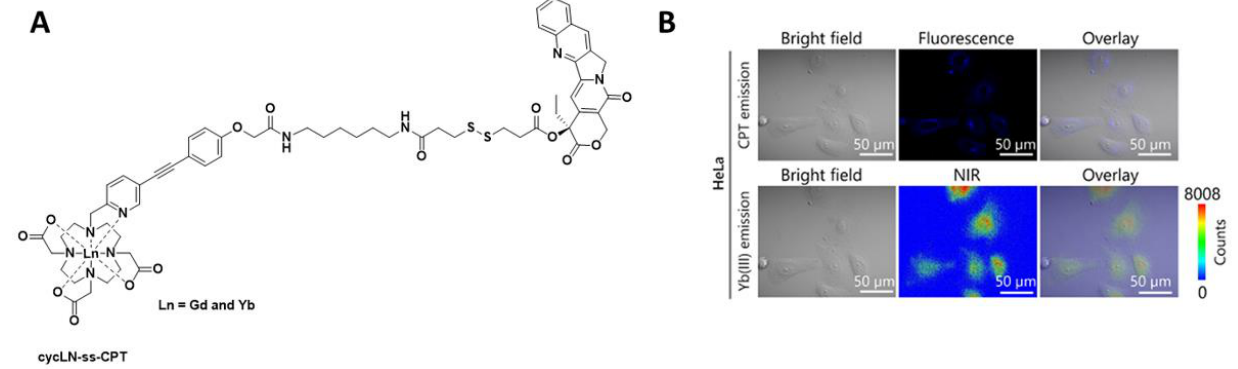
Figure 6. ( A ) Chemical structure of cycLN-ss-CPT. ( B ) NIR imaging of YbNPs in HeLa cells; CPT emission λ ex 370 nm and λ em 400 –450 nm; Yb(III) emission λ ex 380 nm and λ em 900 – 1700 nm. Re- printed (adapted) with permission from Ref. [54]. Copyright 2021 American Chemical Society.